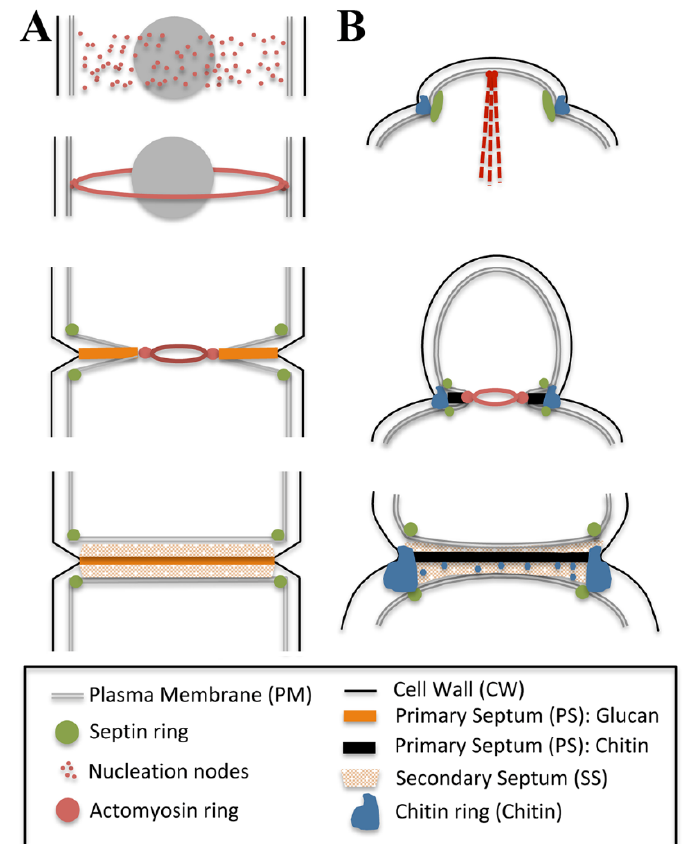
Figure 2. Septum assembly in yeasts: S. pombe ( A ) and S. cerevisiae ( B ). The schemes represent the temporal sequence of the process, from the early stages involved in the selection of the septation site (upper panels) to the assembly of the secondary septa (lower panels). The final stages in cell separation are not depicted. For additional details in the process, see text.